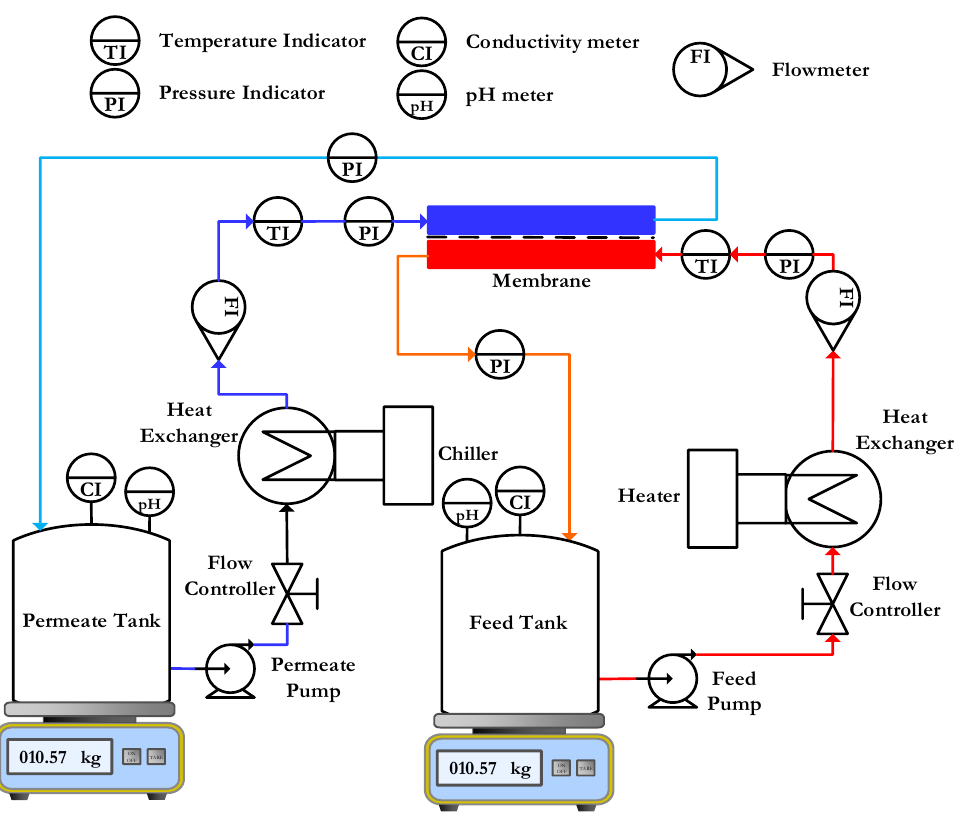
Figure 5. Process flow diagram of the lab scale flat sheet DCMD experimental setup.